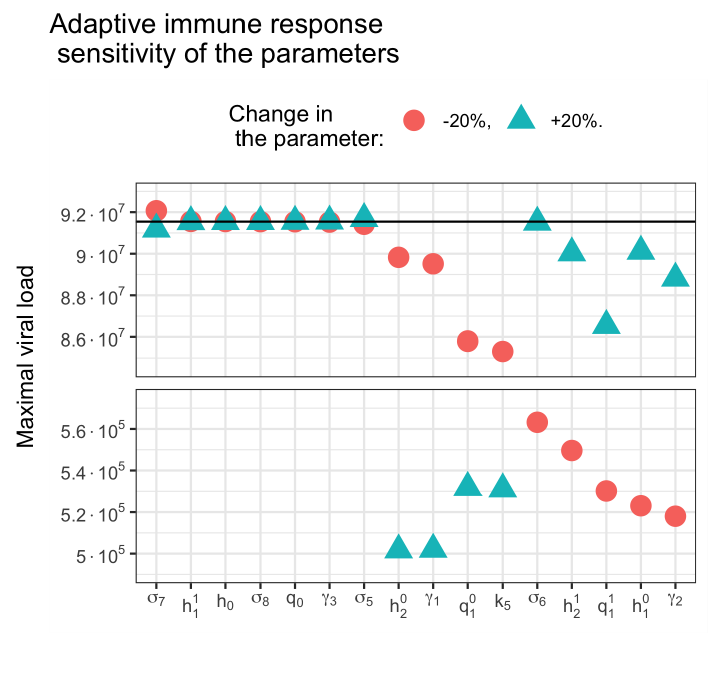
Figure 16. Sensitivity analysis of the adaptive immune response model parameters. Maximal viral load with an increase of 20% (triangles) and a decrease of 20% (dots) of each parameter compared to its value from the control set of parameters (solid